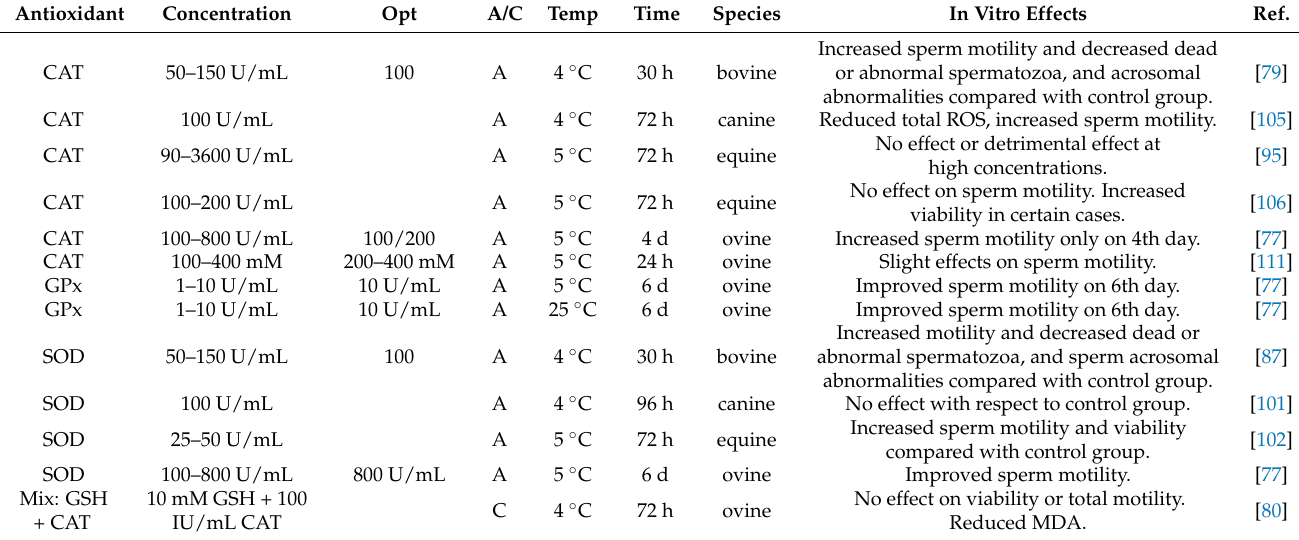
Table 1. Effects of enzymatic antioxidants in liquid cooled storage on sperm